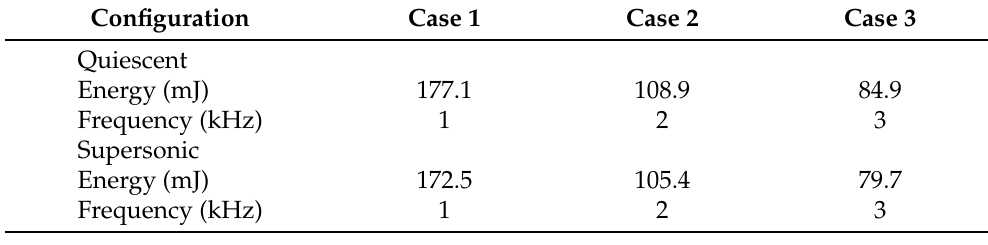
Figure 2. Model (side view). Adapted from [48].